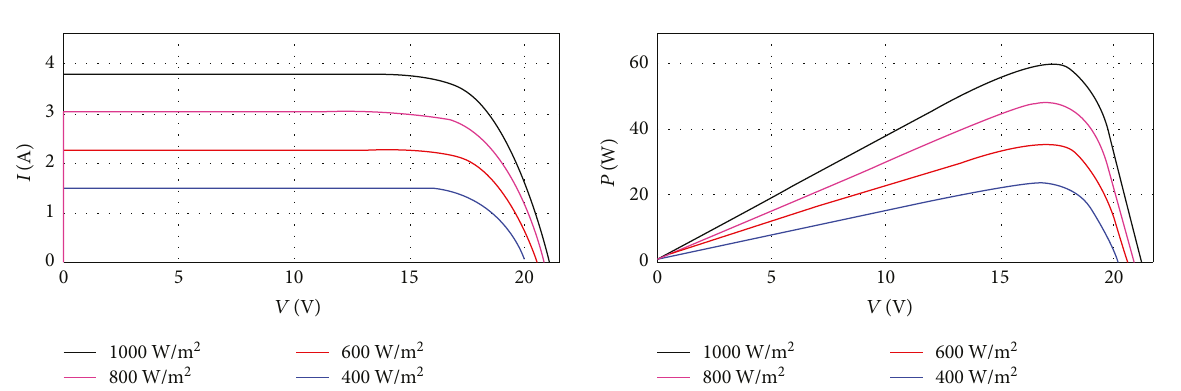
Figure 5: Model of (2).